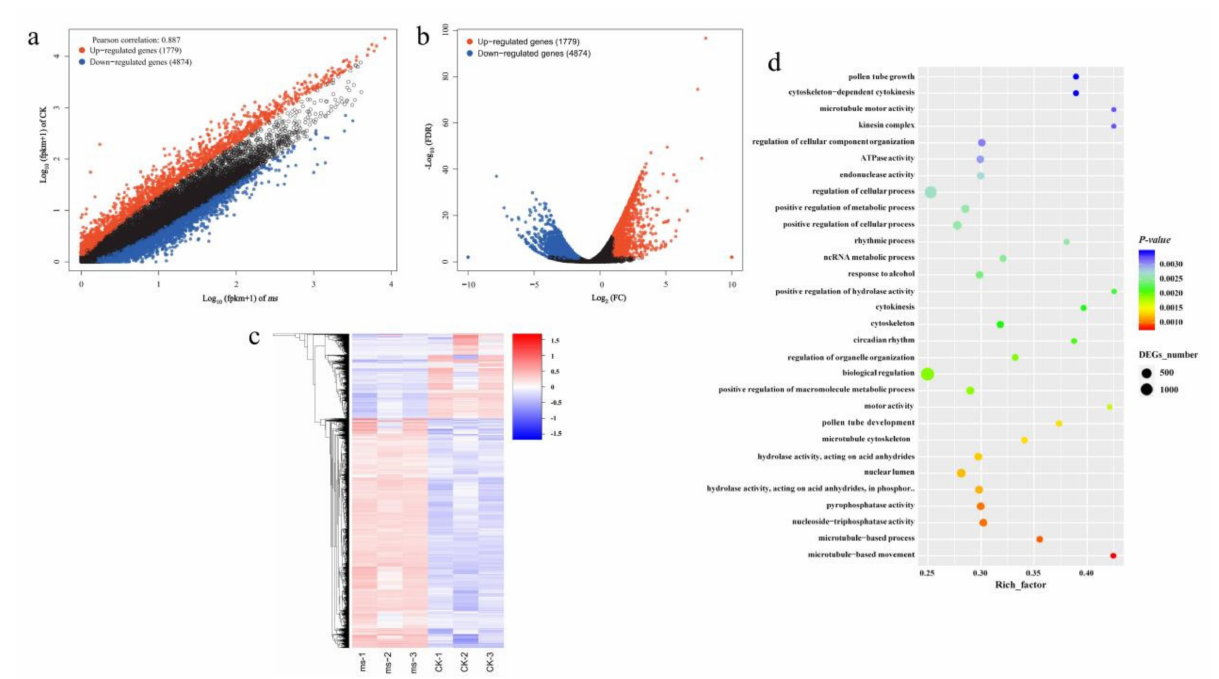
Figure 4. The expression profiles of the identified DEGs. Differences and characterizations in the genes’ expression profiles between CK and ms : ( a ) scatter plots were used to evaluate the differences in the expression of genes between the CK group and the ms group, and the values plotted on the x- and y -axes were the averaged normalized signal values of each group (log10 fpkm + 1); ( b ) volcano plots were used for visualizing the differential expression of genes between the CK group and the ms group. The vertical lines correspond to a 2.0 fold (log2 fold change). Red and blue points represent significant DEGs with an FDR ≤ 0.05, log2 (fpkm + 1) > 0( a ) and log2 (fold change) > 1 ( b ); ( c ) the top 30 pathways of KEGG functional enrichment among DEGs; ( d ) the coloring indicates a p -value that is higher in blue and lower in red, and a lower p -value indicates a more significant enrichment. The point size indicates the number of